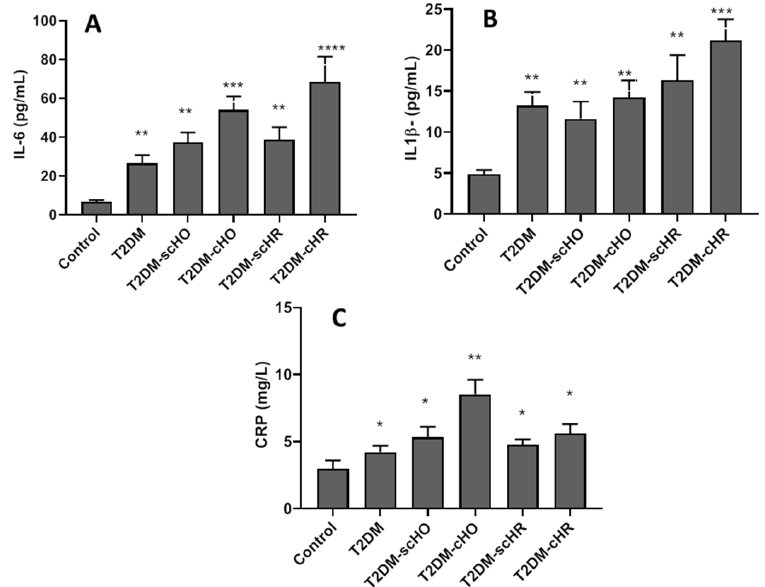
Figure 2. Serum levels of IL-6 ( A ), IL1- β ( B ) and CRP ( C ) in different studied populations. Data are means ± SD, and *, **, *** and **** indicate significant differences between all patient groups with healthy populations at p < 0.05, p < 0.01, p < 0.001 and p < 0.0001, respectively. T2DM: type 2 diabetes mellitus; SC-HO: subclinical hypothyroidism; C-HO: clinical hypothyroidism; SC-HR: subclinical hyperthyroidism; C-HR: clinical hyperthyroidism.